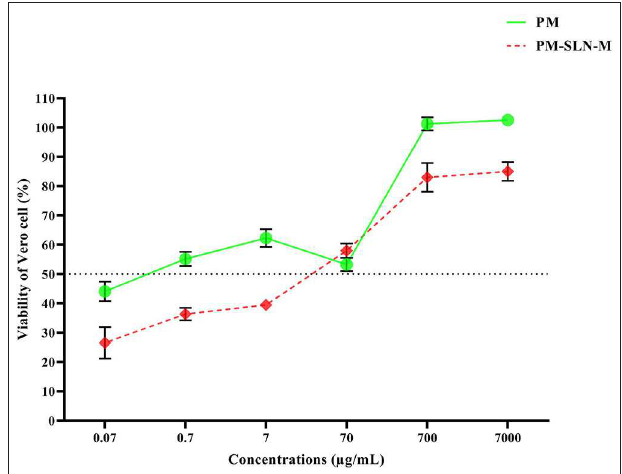
FIGURE 4 | Comparison of anti- Toxoplasma activity of PM and PM-SLN-M according to different concentrations.